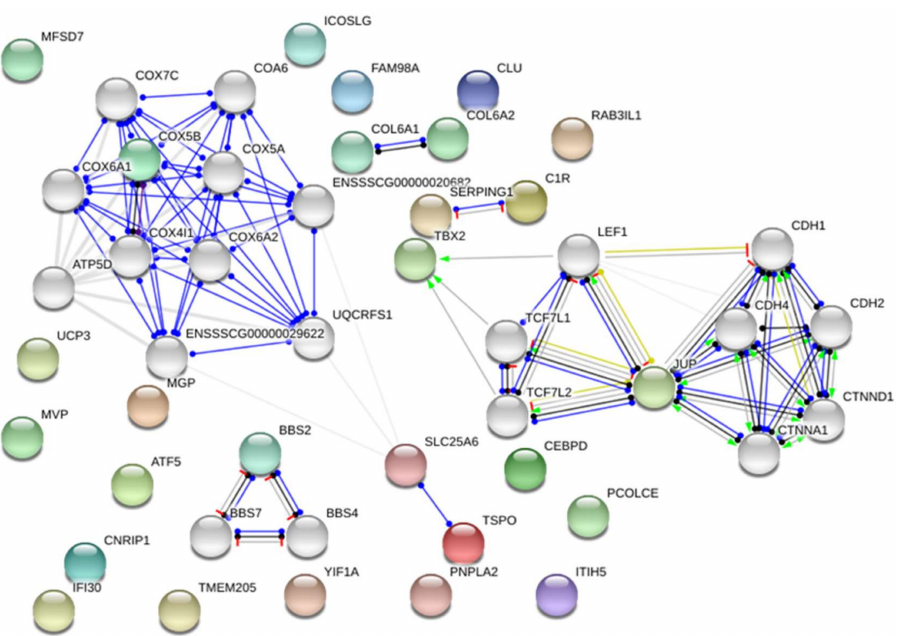
Figure 1. The differentially expressed genes were up-regulated in muscles of pigs with higher muscle mass. Detected genes were coloured and showed no more than 20 interactions (genes marked in grey); line shape indicates the predicted mode of action. Lines coloured indicate the predicted mode of action (red—interactions that were experimentally determined; blue—interactions from curated databases; black—co-expression; green—text mining associations and interactions based on relevant publications mentioning a transfer from other organisms, yellow—transcriptional regulation). Network were presented as a scalable vector graphic and based on Sus scrofa reference.